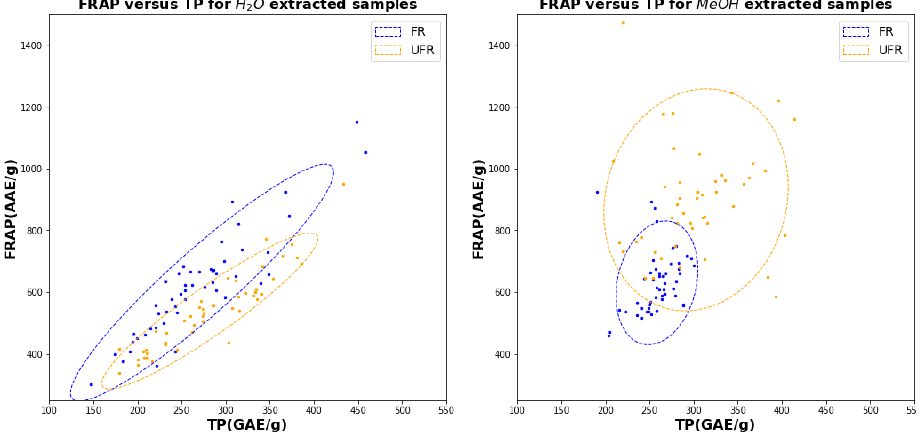
Figure 8. Scatter diagram for TP versus FRAP using water (left) and methanol for 51 FR samples (blue) and 47 UFR samples